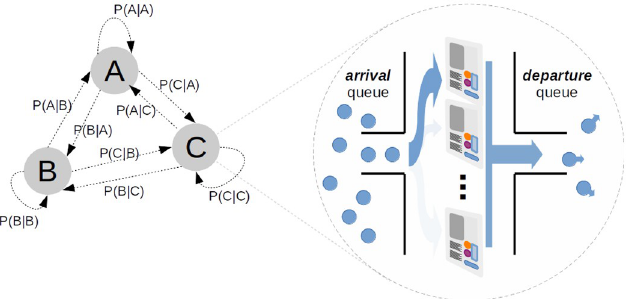
Fig 2. Queueing Network and Markov Chains. The flow of people from one zone to another can be controlled by a first-order Markov Chain (see. Eq A.1 in S1 Appendix) Upon arriving at a location, individuals will queue to use one (of possibly many) identical TUIs (e.g. a bank of ATM machines). After interacting with the TUI, they join a ‘departure’ queue (effectively hanging around at that location) until finally rejoining the Markov Chain and moving on to a new zone/location. A pair of rate parameters associated with a particular TUI type ( * Pois ( λ TUI )) and zone ( * Pois ( λ )) determine how long they queue in the ‘arrival’ and ‘departure’ queues Z